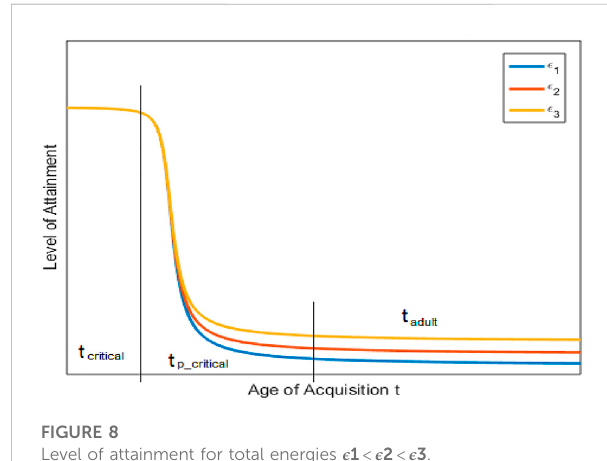
FIGURE 8 Level of attainment for total energies  1 <  2 <  3